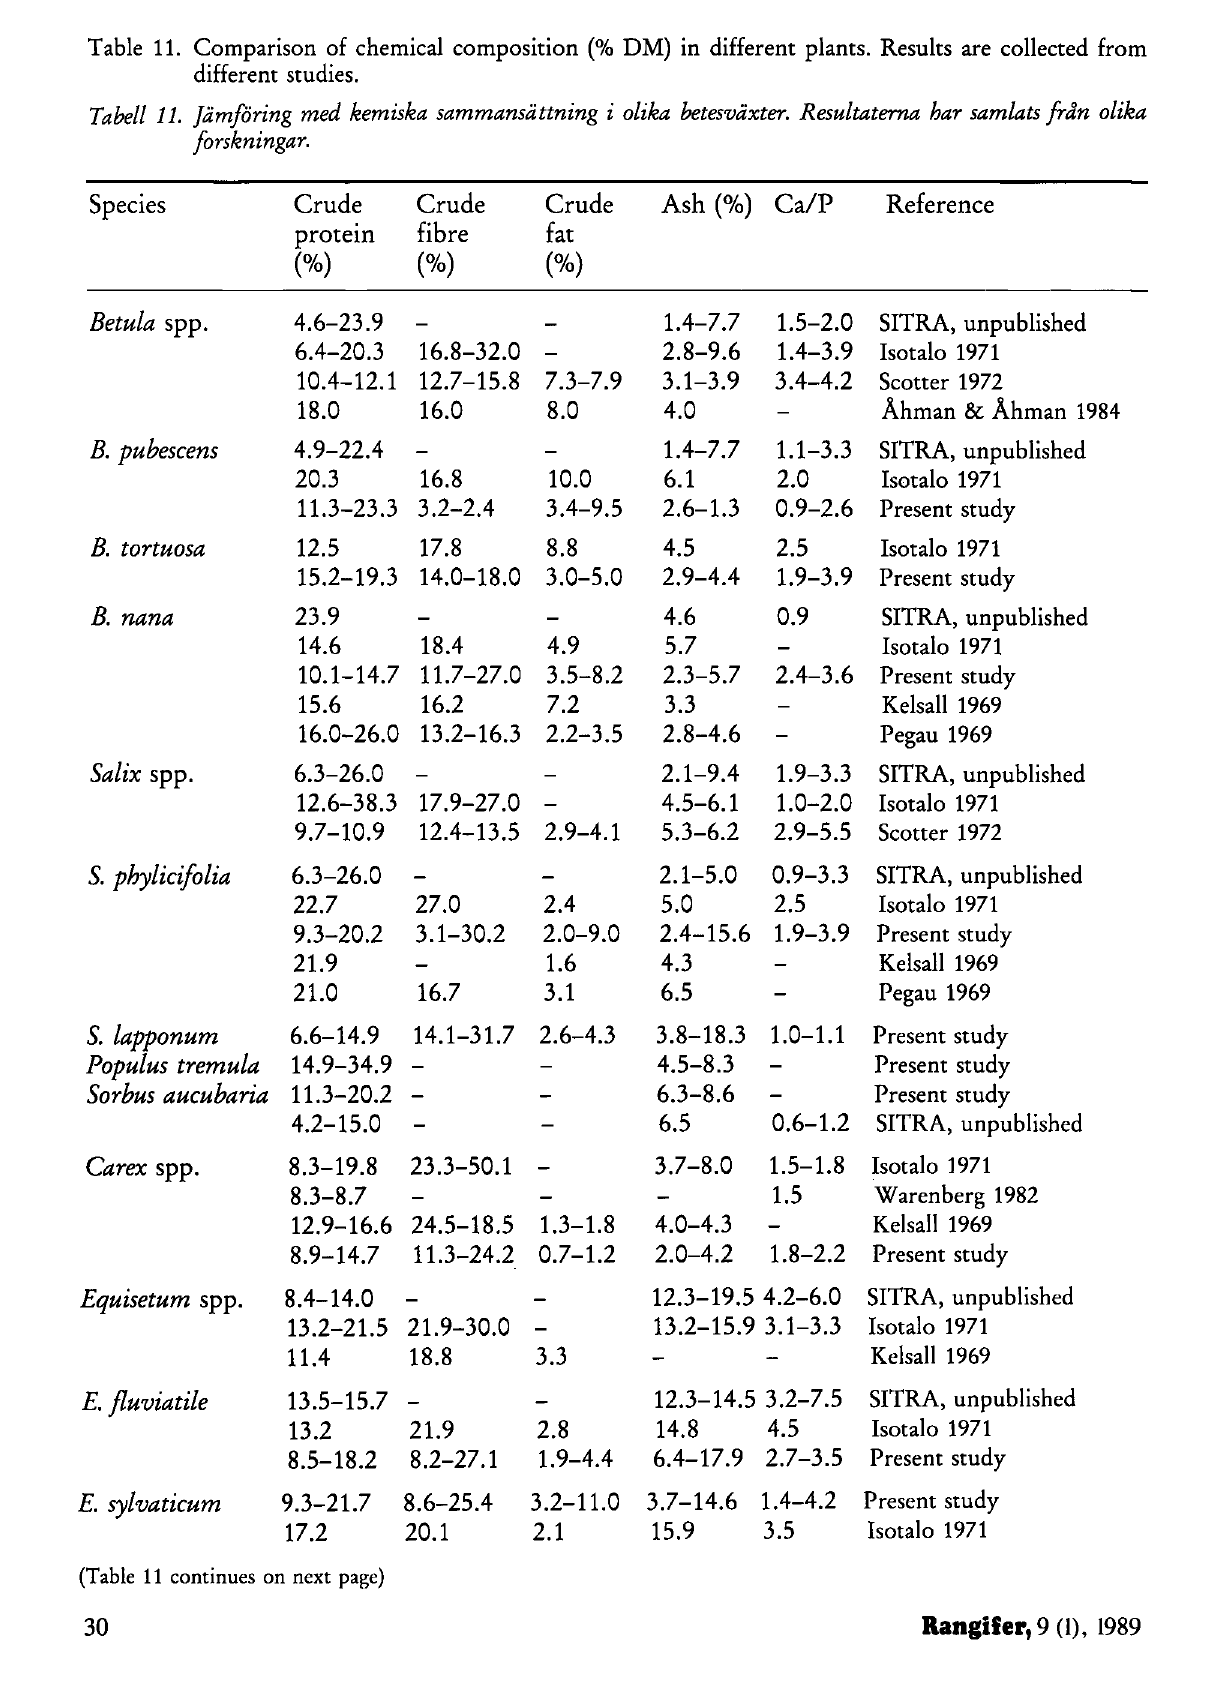
Table 11. Comparison of chemical composition (% DM) in different plants. Results are collected from different studies. Tabell 11. Jamforing med kemiska sammansattning i olika betesvdxter. Resultaterna har samlats från olika forskningar.